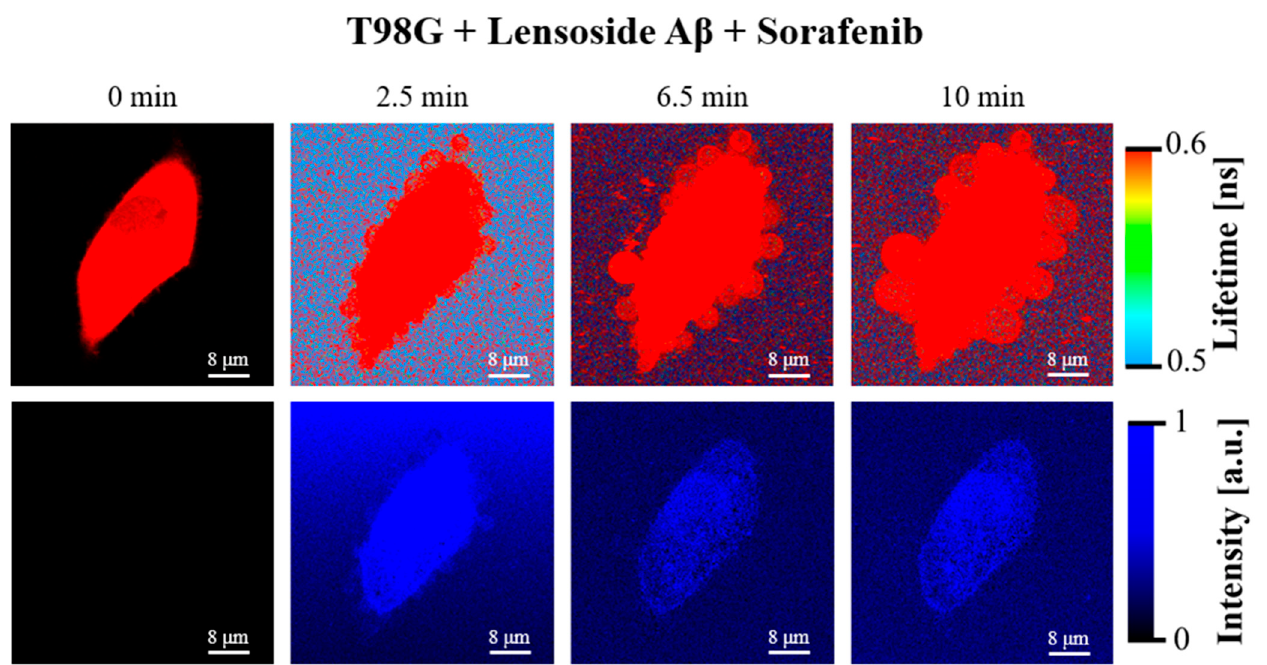
Figure 14. FLIM images of T98G cells incubated with lensoside A β and sorafenib for the indicated different periods. The lower panel presents the same images created solely on the fluorescence lifetime component of 0.01 ns, representing selectively lensoside A β and showing its distribution in the examined system. See also Figure S4 for images of the other cells. Note a pronounced cell membrane deformation, formation of extracellular vesicles, and diffusion of lensoside A β into the cell.